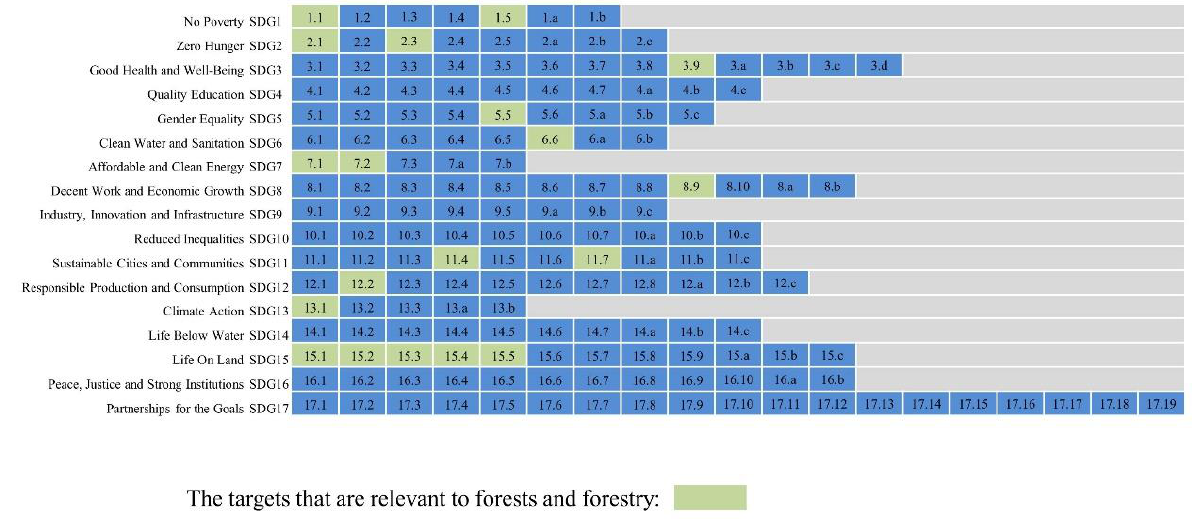
Figure 2. The Sustainable Development Goals (SDGs) and the targets that are relevant to forests and forestry.